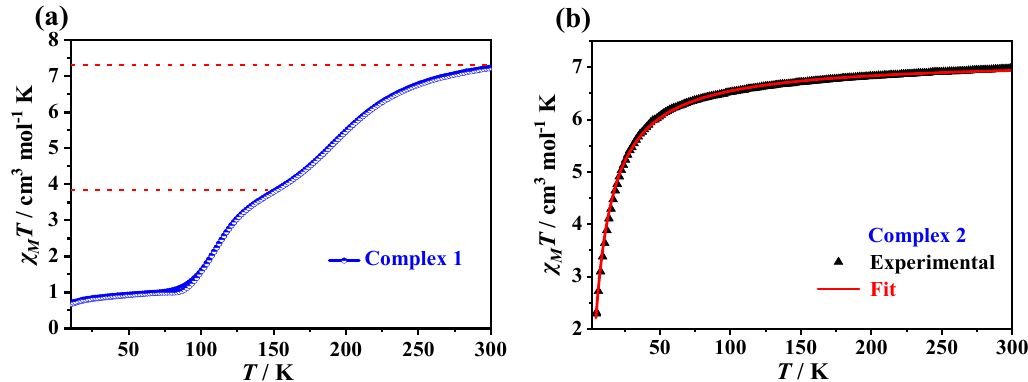
Figure 1. Magnetic susceptibilities ( χ M T ) of ( a ) {[Fe(abpt-TPE)(NCS) 2 ] 2 (bpym)}·2MeOH·2MeCN ( 1 ) and ( b ) {[Fe(abpt-TPE)(NCS) 2 ] 2 (bpym)}·2CH 2 Cl 2 ( 2 ) as functions of T . The solid red line shows the line of best fit obtained using the PHI program.